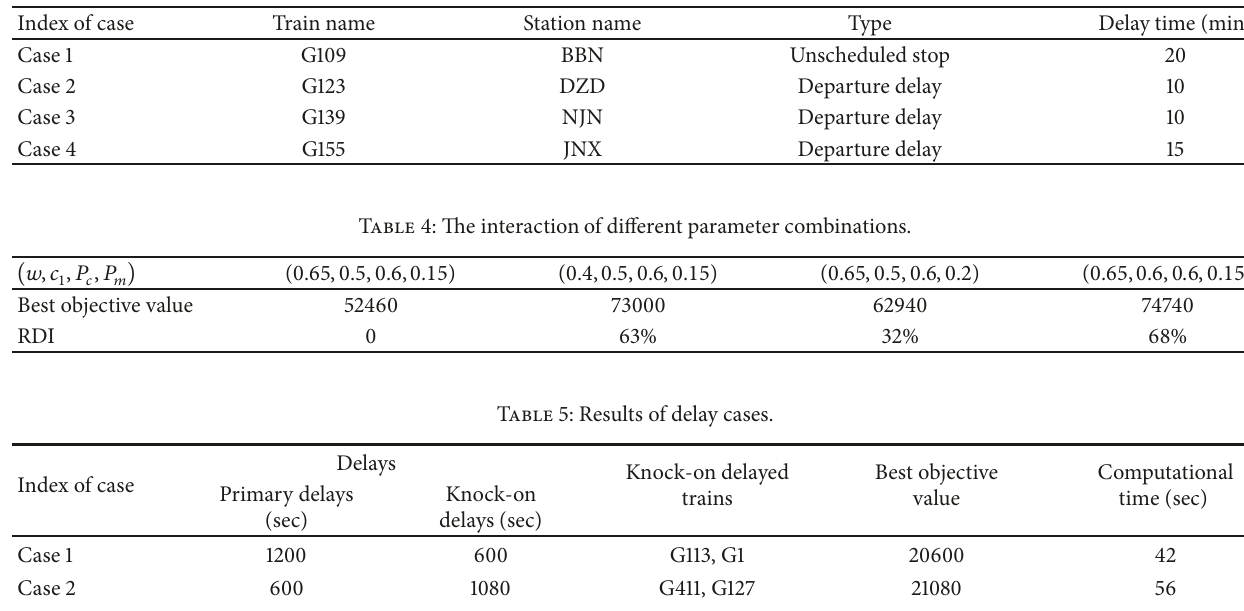
Table 3: Delay cases description.